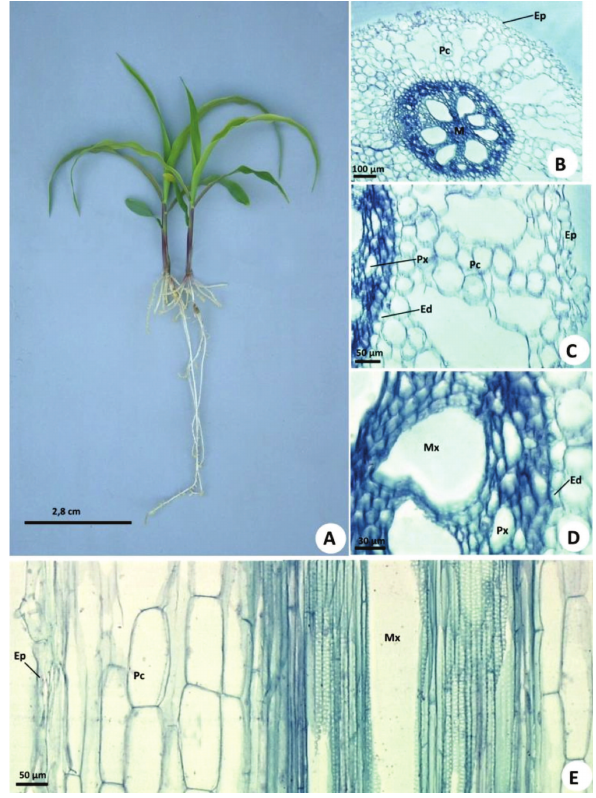
Figure 5. a) Corn plant grown in nutrient solution containing 300 µmol L -1 Al. b, c, d) Transversal sections of the root. d) Details of the endodermis with “U” thickening. e) Longitudinal sections of the root. Ed, endodermis; Ep, epidermis; F, phloem; M, pith; Mx, metaxylem; P, pericycle; Pc, cortical parenchyma; and Px,